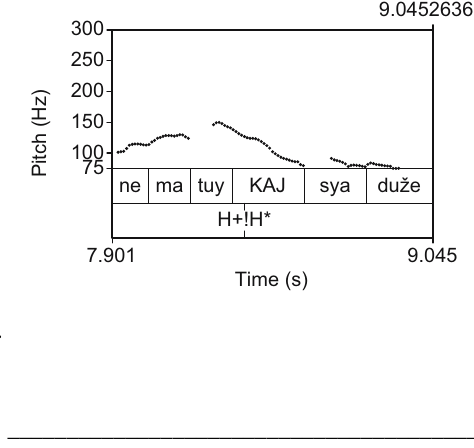
Figure 4: Request with